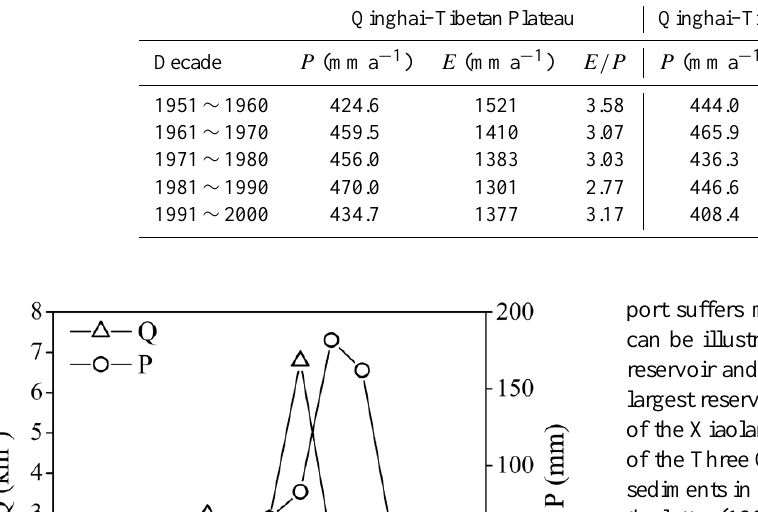
Table 2. Decadal averages of precipitation and evaporation. P is annual precipitation, E denotes annual pan evaporation, E/P is the ratio of the evaporation to precipitation, which shows the dryness of the climate. Data quoted from Yang et al. (2004). Qinghai–Tibetan Plateau Qinghai–Tibetan Plateau and Loess Plateau